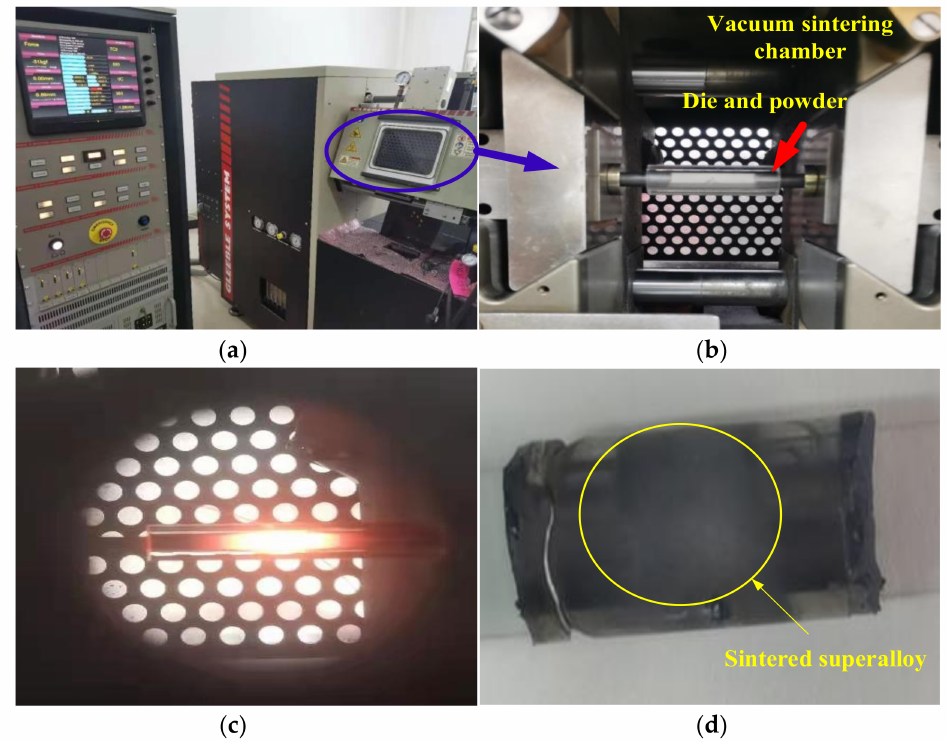
Figure 7. Experimental process and alloy sample after sintering: ( a ) vacuum sintering chamber; ( b ) vacuum sintering chamber and clamped mold and powder; ( c ) Inconel 718 alloy sample during sintering; ( d ) Inconel 718 alloy sample after